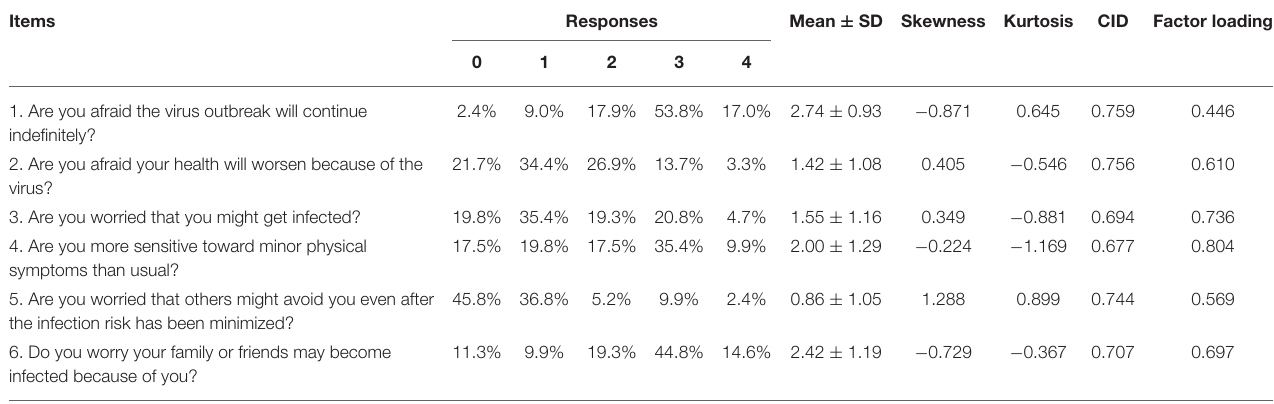
TABLE 2 | Factor structure of the stress and anxiety to viral epidemics-6 items applied to medical students.